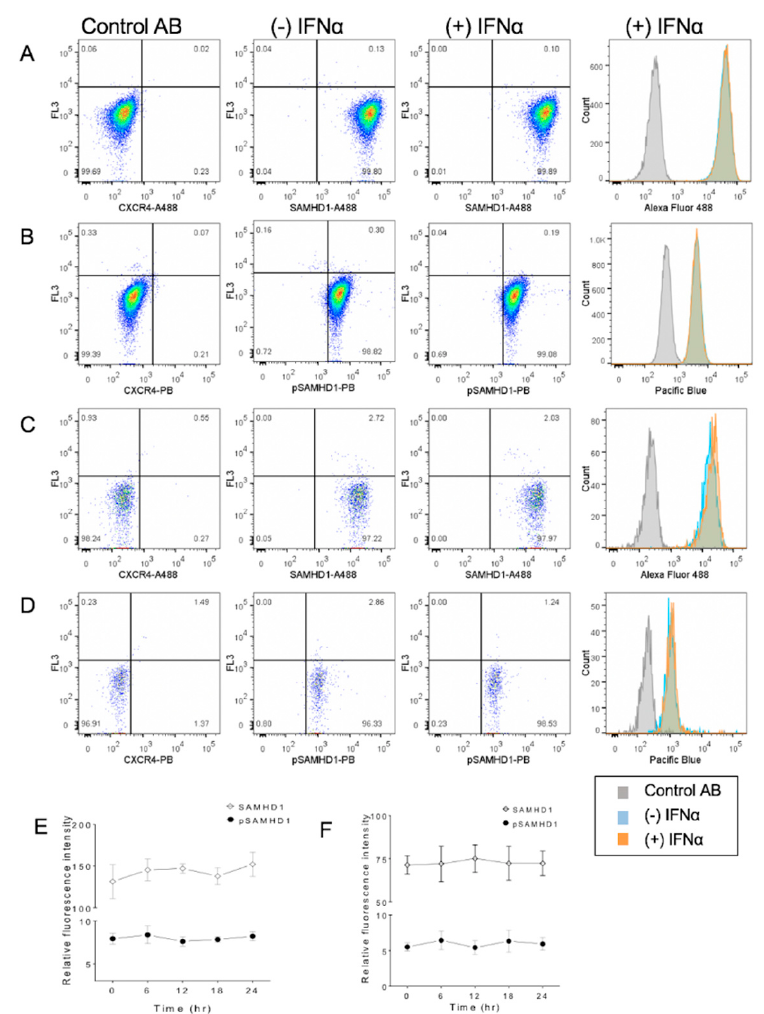
Figure 4. Flow cytometric assessment of subcellular localization of total and phosphorylated SAMHD1 in